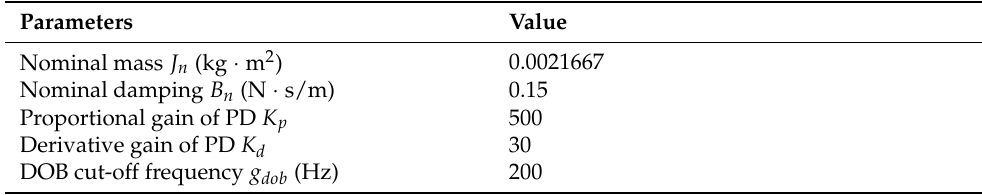
Table 3. Parameters of control system in